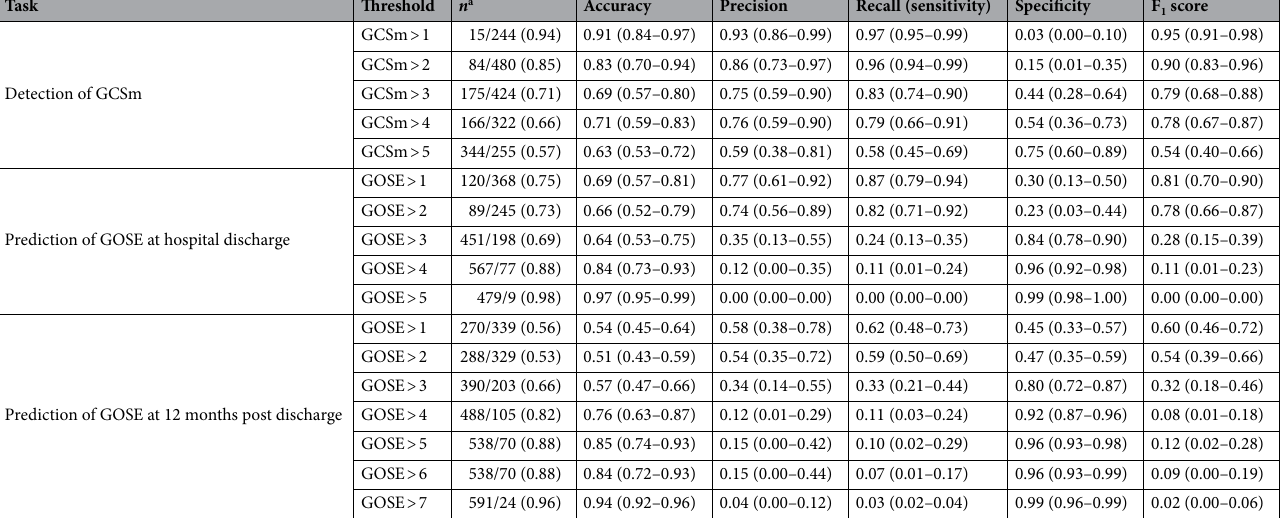
Table 2. Classification performance metrics of optimally discriminating models. Classification metrics [mean (95% confidence interval)] corresponding to models trained on observation windows that maximize the area under the receiver operating characteristic curve (AUC) for each threshold (Figs. 2a, 3a, and Supplementary Fig. S5). Confidence intervals were derived using bias-corrected bootstrapping (1000 resamples) and represent the variation across repeated cross-validation folds (5 repeats of 5 folds) and nine missing value imputations. Acronyms: motor component score of the Glasgow Coma Scale (GCSm) and Glasgow Outcome Scale–Extended (GOSE). a Count distribution of negative vs. positive cases with the proportion of the most represented case, equivalent to the no information rate, in